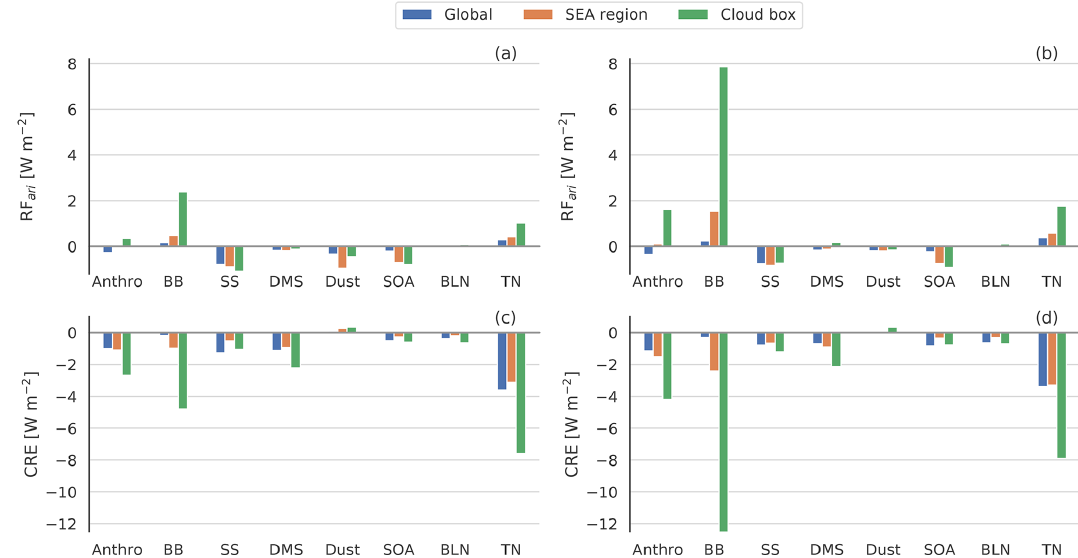
Figure 9. UKESM1-simulated radiative forcing from the aerosol–radiation interaction (RF ari ) and cloud radiative effect (CRE) for different sources. Panels (a) and (b) are the annual and BB season means of RF ari , and panels (c) and (d) are the annual and BB season means of CRE. Anthro, BB, SS, DMS, Dust, SOA, BLN, and TN represent anthropogenic, BB, sea-salt, DMS, dust, SOA, boundary layer nucleation, and total aerosol nucleation sources respectively. Blue, orange, and green colours represent the mean values averaged over the global, investigated SEA area, and cloud box regions